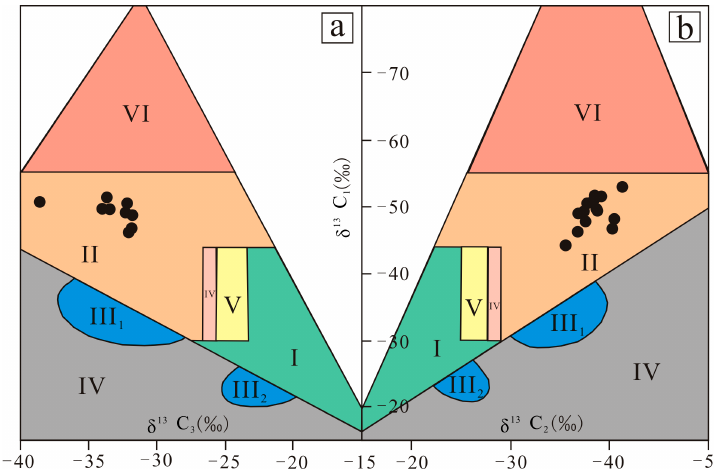
Figure 6. Cross plots of carbon isotope ( a ) CH 4 versus C 2 H 6 ; ( b ) CH 4 versus C 3 H 8. Ⅰ -coal-type gas; Ⅱ oil-type gas; Ⅲ —carbon isotope inversion gas; Ⅳ —humic and sapropelic gas; Ⅴ —mixure of coal-type and oil-type gas; Ⅵ —biogas and sub biogas.